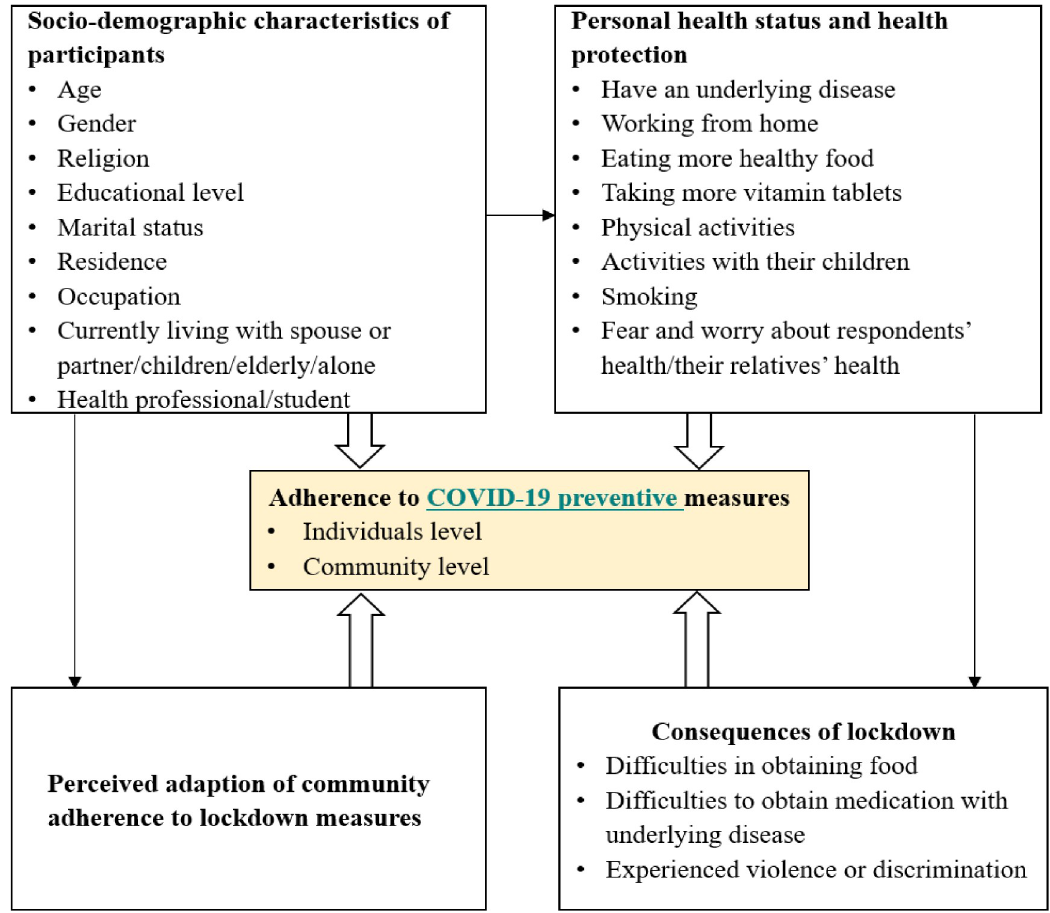
Fig 1. Conceptual framework with the individual and community features